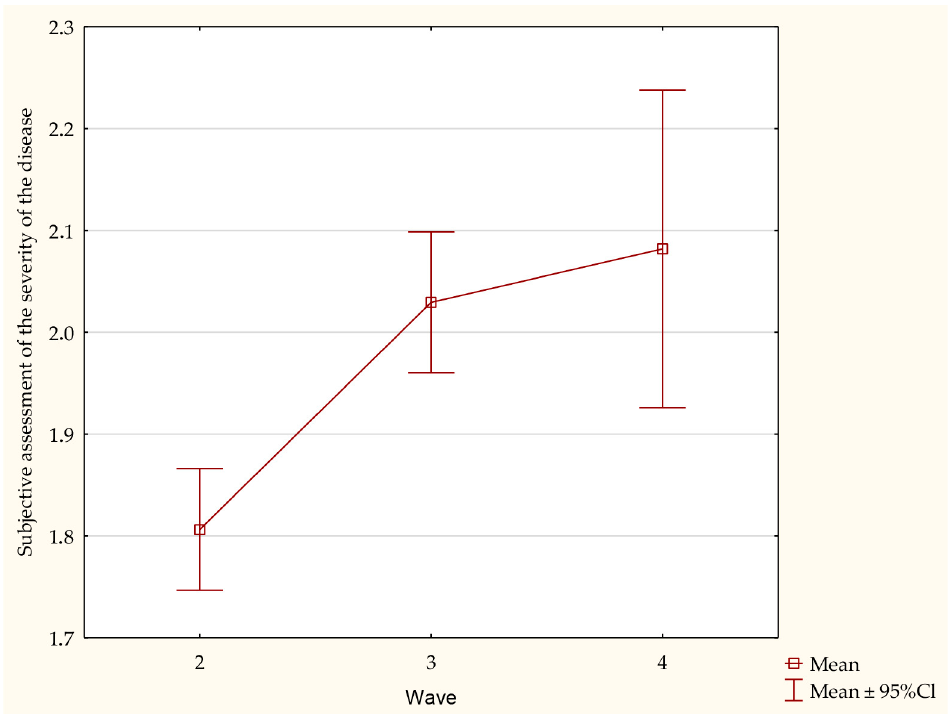
Figure 1. Comparison of the subjective assessment of SARS-CoV-2 infection severity in reference to the respective stages of the study.